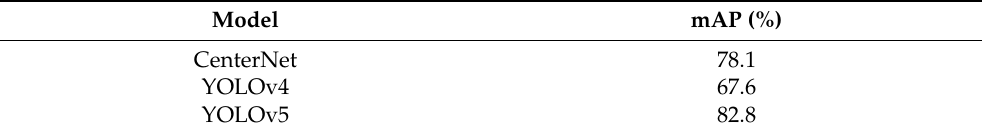
Table 4. Comparison detection of mAP between CenterNet, YOLOv4, and YOLOv5 deep-learning algorithms.